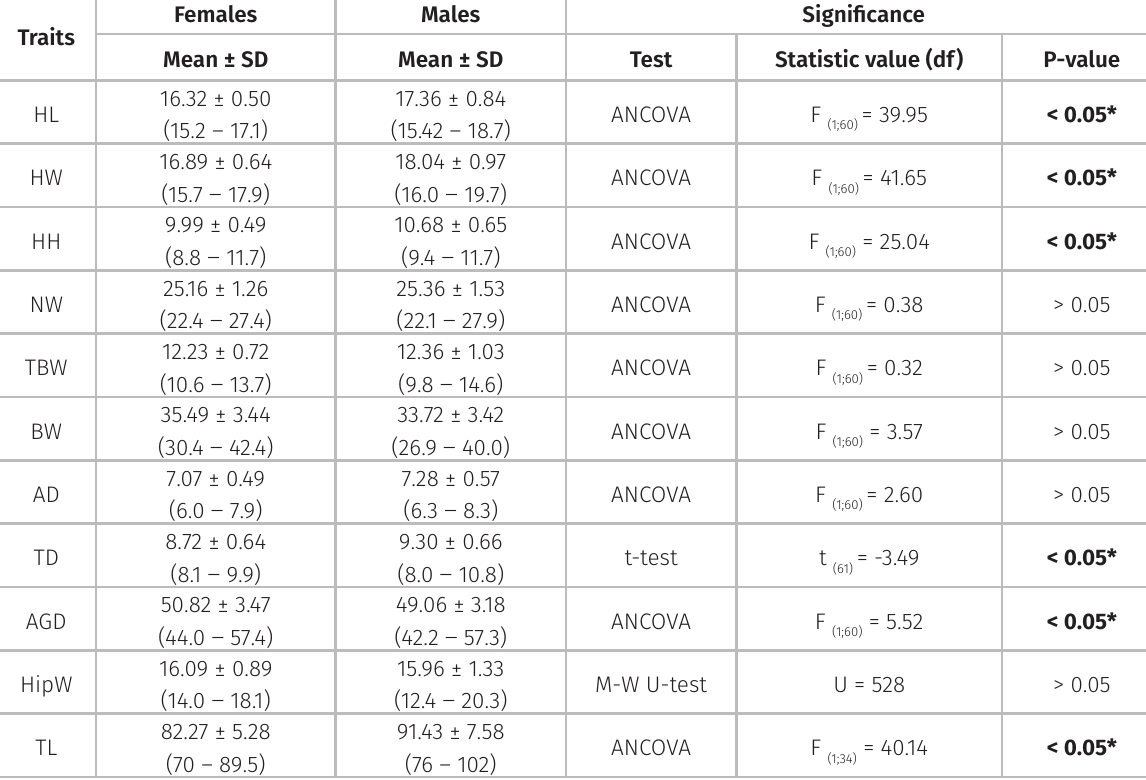
Table II. Comparison of morphometric variables between females and males of Phymaturus extrilidus . Mean ± standard deviation (SD), range between parenthesis, sample size (N = 27 females; N = 36 males; except N = 17 females for BW). Statistical test, F, t or U values, and degree of freedom (df). Dimorphic traits are indicated with bold and asterisk ( P <